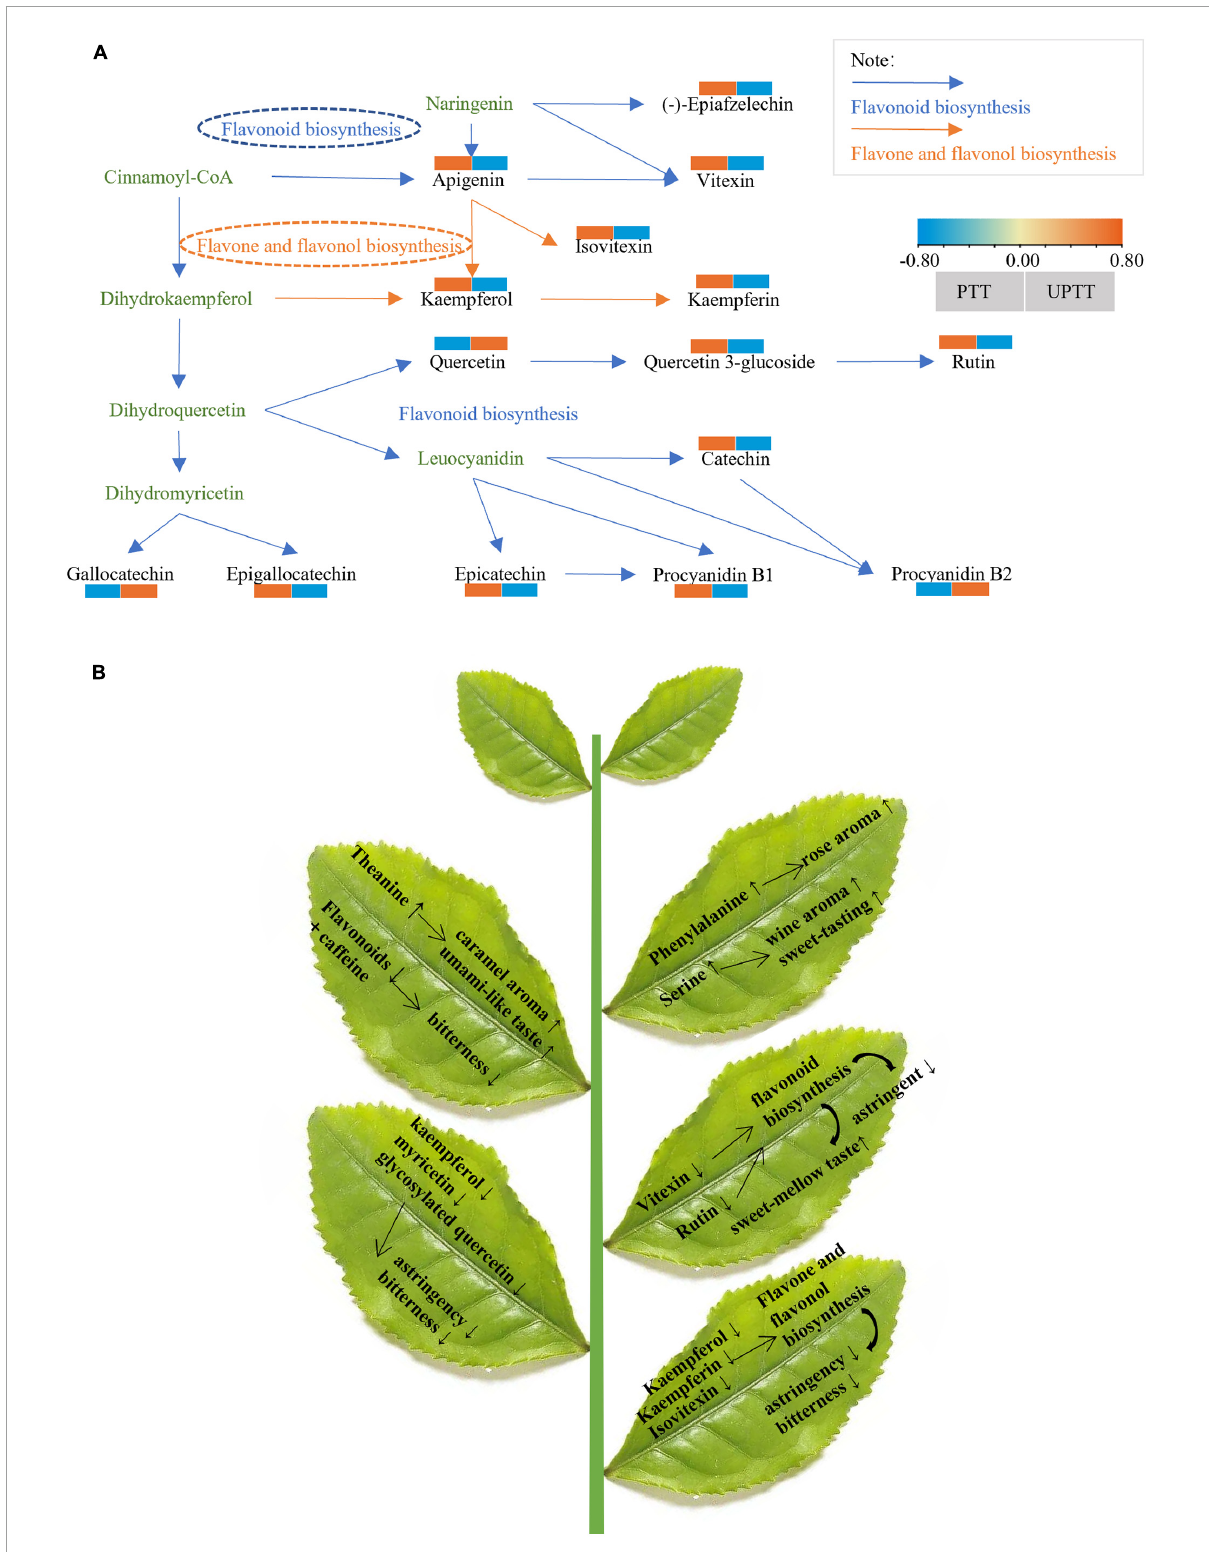
FIGURE8 Reconstruction of the flavonoid biosynthetic pathway (A) ; Schematic diagram of changes in metabolism after unpruning (B) .